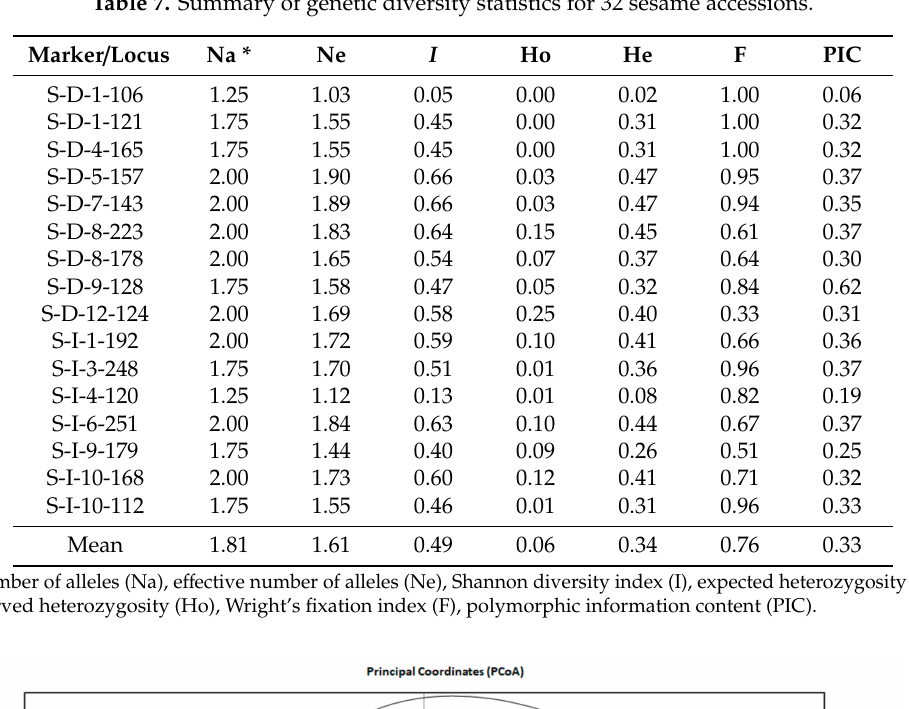
Table 7. Summary of genetic diversity statistics for 32 sesame accessions.